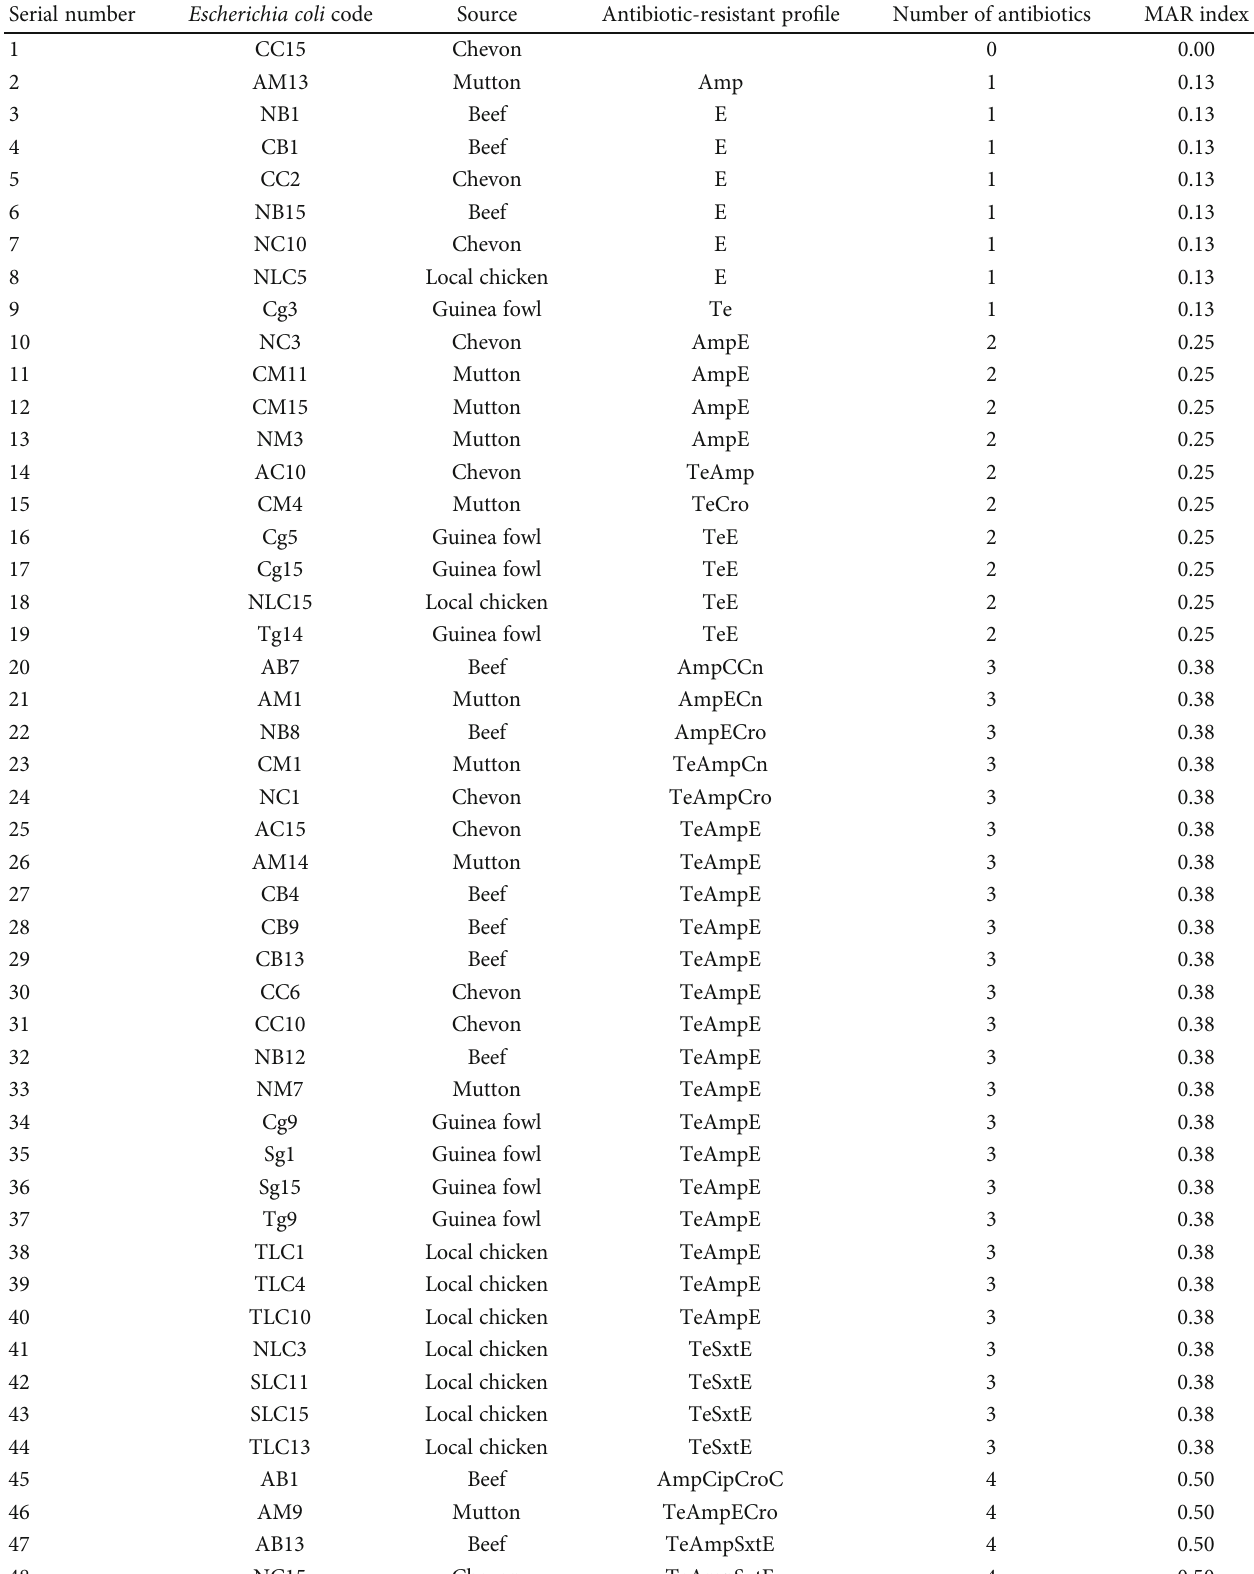
Table 3: Antibiotic resistance pro fi le and multiple antibiotic resistance index of individual Escherichia coli isolated from meat samples in Tamale